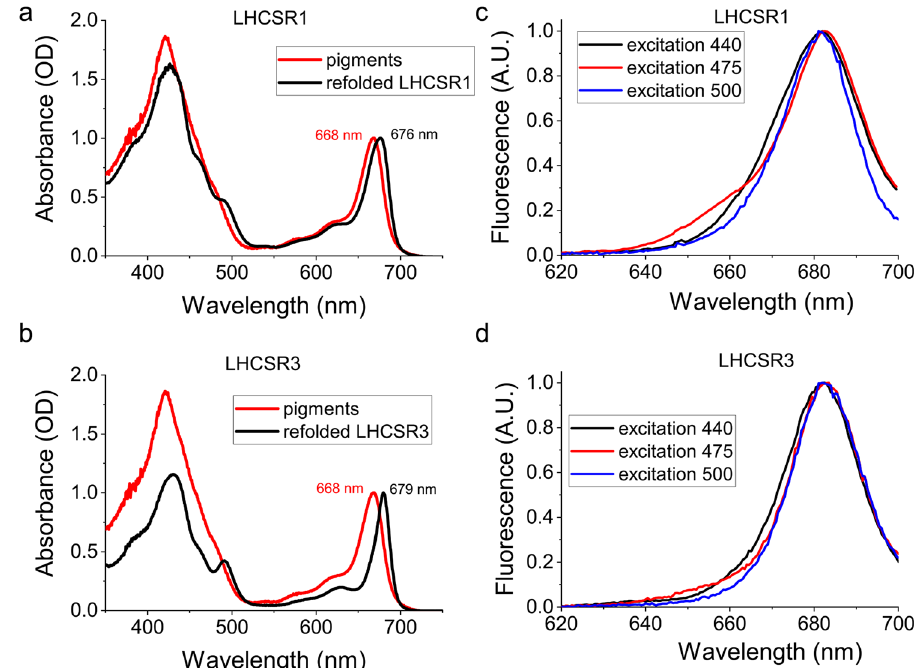
Figure 3. Absorption and fluorescence properties of recombinant LHCSR1 and LHCSR3 refolded in vitro. Absorption spectra were recorded from 350 to 750 nm and compared to the absorption spectra of free pigments in the same detergent solution (Hepes 20 mM, sucrose 0.1 M and beta-dodecyl maltoside 0.03%) ( a , b ). Fluorescence emission spectra ( c , d ) were measured in the 610–700 nm range upon excitation at 440, 475